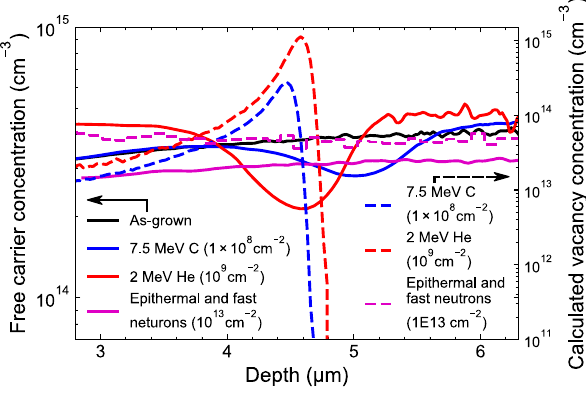
Figure 2. Free-carrier concentration profiles of as-grown, ion implanted, and neutron irradiated n-type 4H-SiC Schottky barrier diodes (SBDs; solid lines, left y axis) and the calculated vacancy concentration profiles (dashed lines, right y axis). The concentration profiles are obtained from the C–V characteristics measured at 200 K [51].